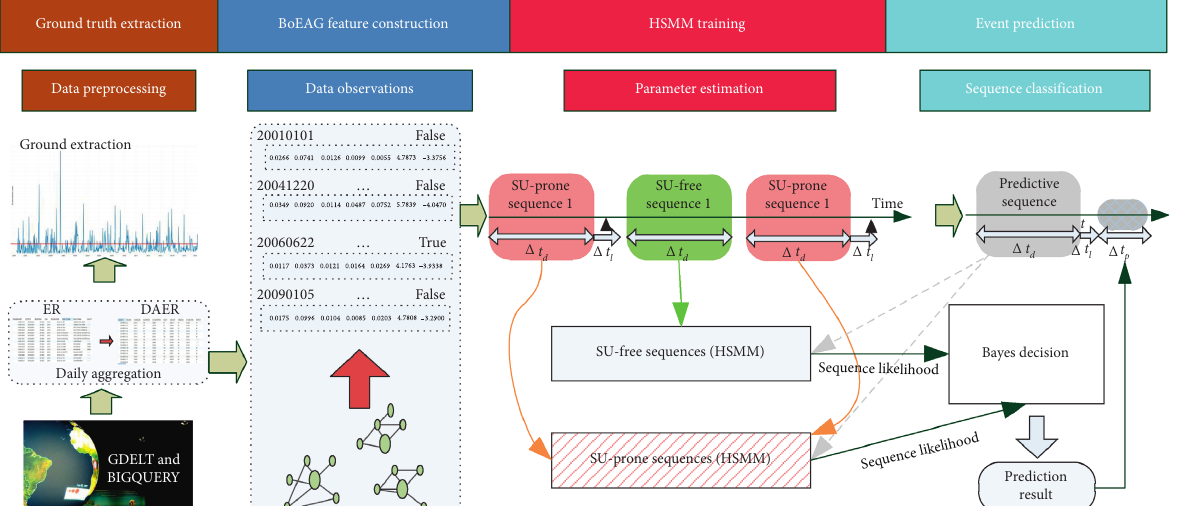
Figure 3: The proposed HSMM-based social unrest event prediction framework: two HSMMs are trained, with one for SU-prone sequences and one for SU-free sequences. SU-prone sequences consist of observations (BoEAG feature) within a time window of length Δ t d preceding a social unrest event ( ▲ ) by lead time Δ t l . SU-free sequences consist of observations at times when no social unrest event was imminent. t is the time the prediction performed at. Δ t p is the prediction period.